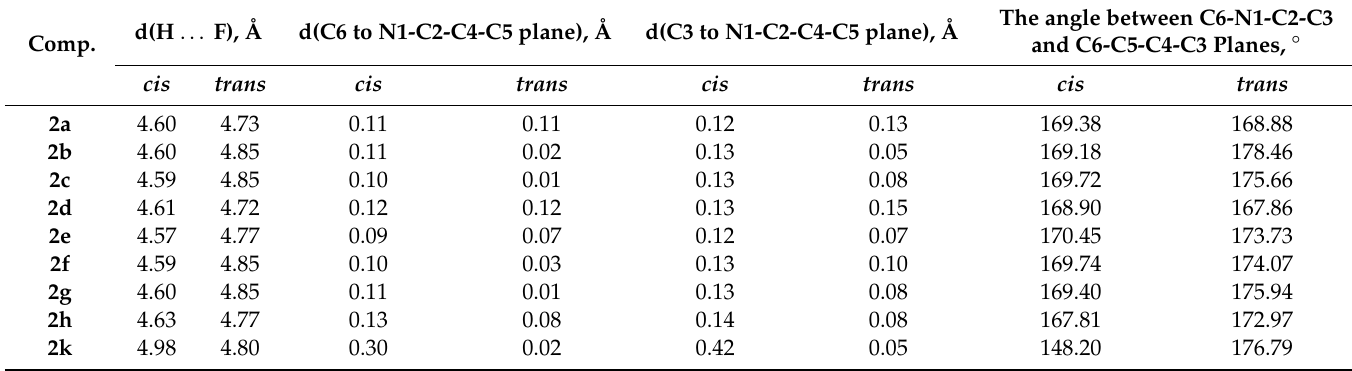
Table 4. Quantum chemical calculation data for compounds 2a – k